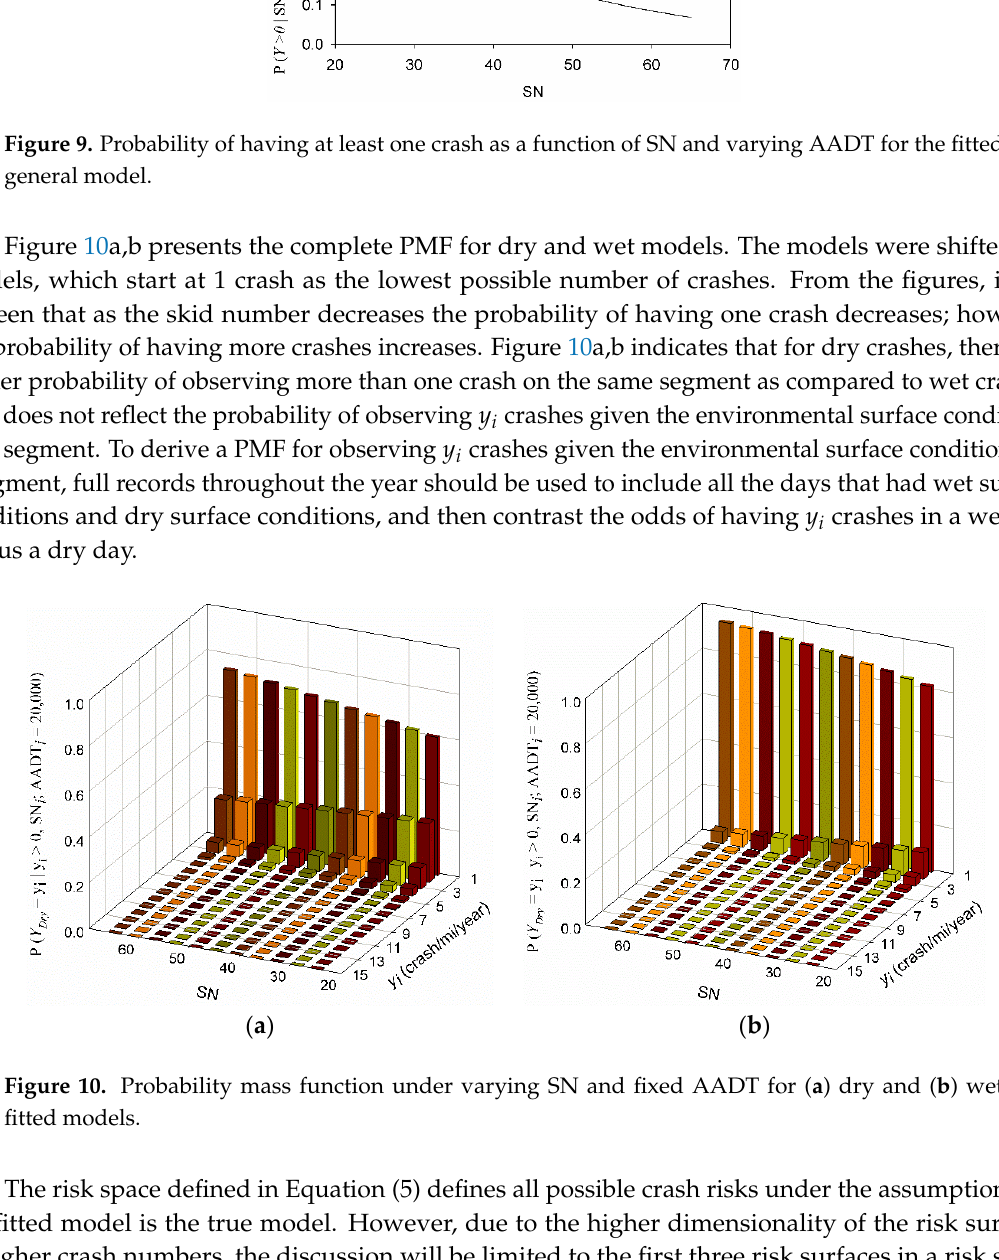
Figure 9. Probability of having at least one crash as a function of SN and varying AADT for the fitted general model.